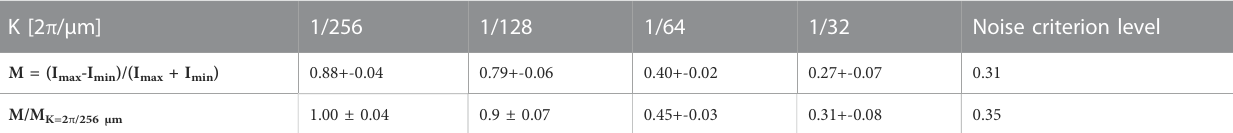
TABLE 1Calculated data for the modulation depthoriginating from asingleline pro fi le (Figure 10 andFigure 11). The noise criterion level is calculated from Eq. 7 fromthenoisede fi nedforpracticabilityasthestandarddeviation(s= σ background )inaRegionofInterest(ROI)outsideofthegridbutclosetothepathofthepro fi le ( σ background =